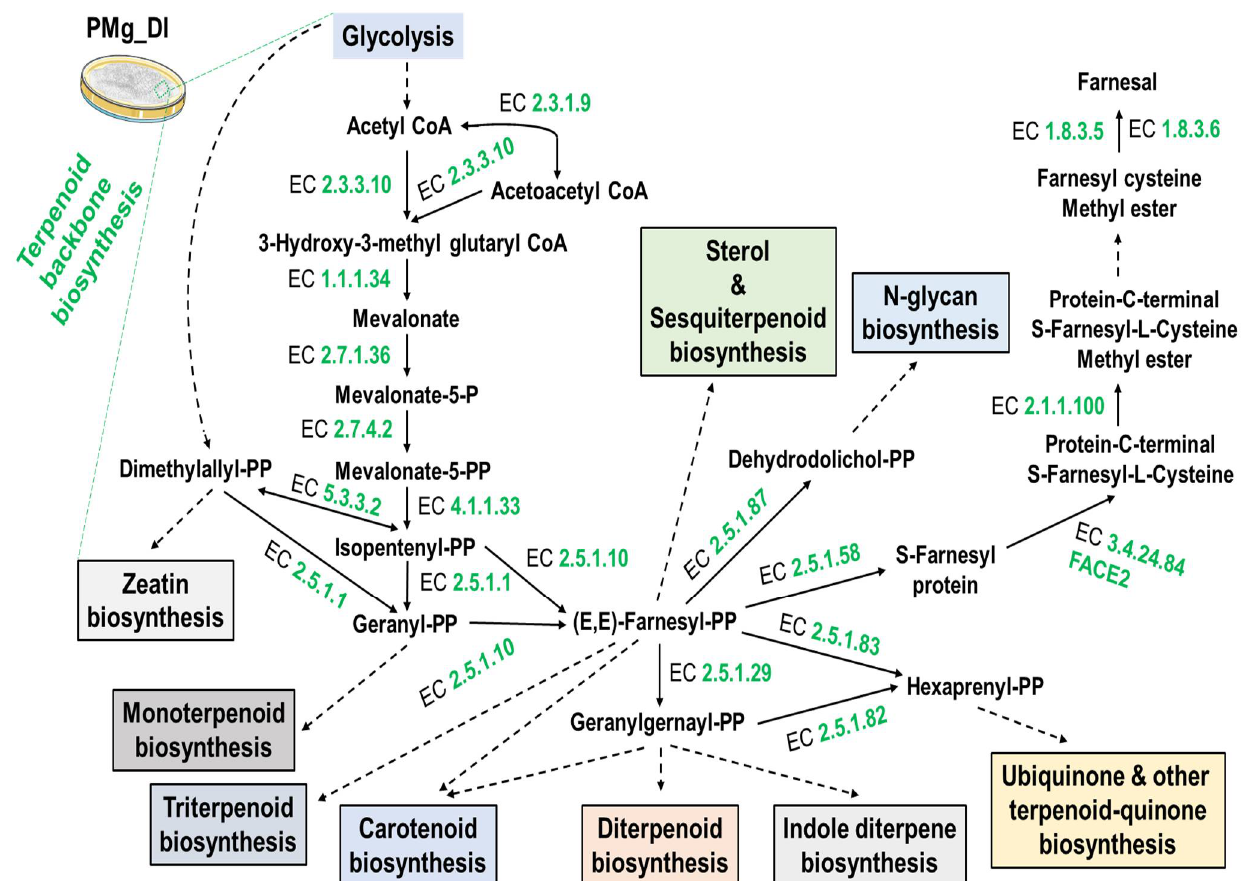
Figure 9. Schematic illustration of terpenoid backbone biosynthesis pathways of M. grisea PMg_D1-associated natural secondary metabolites synthesis and linked downstream pathways. The sysnames of enzymes related to the biosynthetic machinery are depicted in green-colored EC numbers: